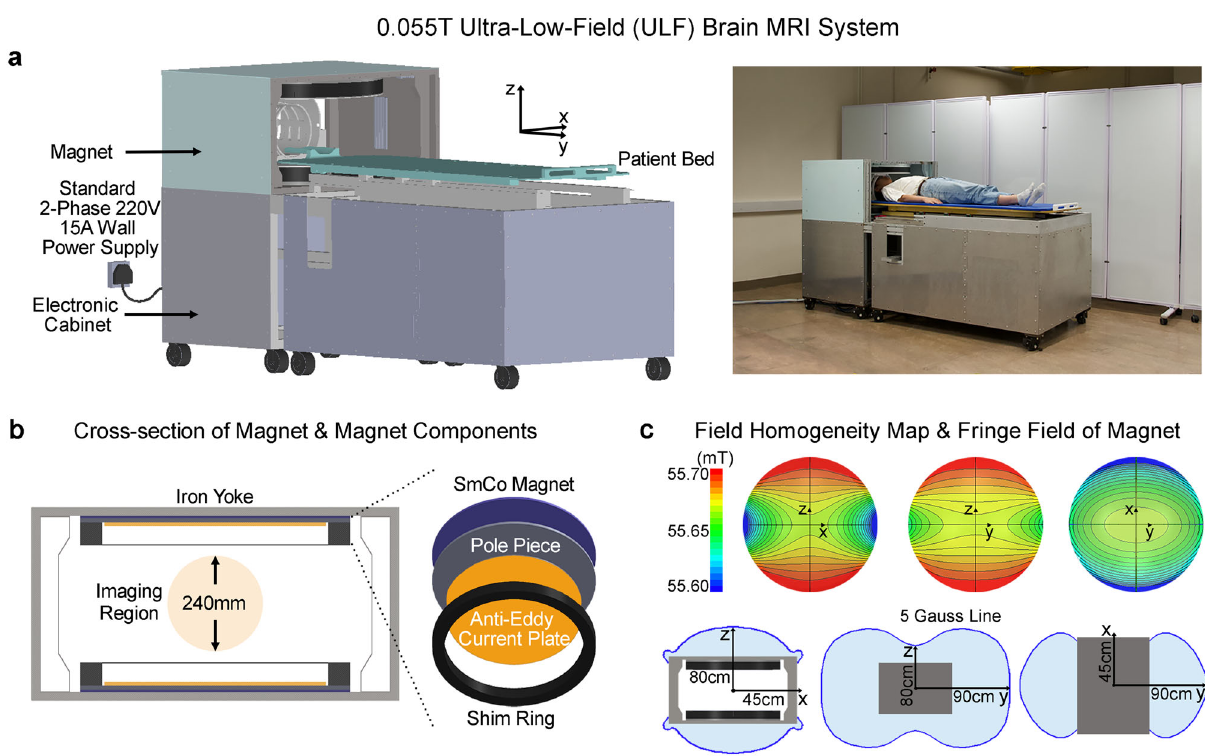
Fig. 1 Prototype of a low-cost low-power and shielding-free brain ultra-low- fi eld (ULF) magnetic resonance imaging (MRI) scanner with homogenous 0.055 Tesla magnetic fi eld and small 5 Gauss fringe fi eld. a With ~2 m 2 footprint and no radiofrequency/magnetic shielding cages, the scanner can be mobile and located on any building fl oor with no special siting requirements. It operates from only a standard alternating current (AC) wall power outlet (50 Hz 2-phase 220 V 15 A). b The 0.055 T magnet utilizes an iron yoke, samarium-cobalt (SmCo) plates, polar pieces, anti-eddy current plates and passive shimming rings, and with adequate opening for patient chest and shoulder (29 cm vertical gap and 70 cm width). c The magnet provides a homogeneity <2000 ppm peak-to-peak over 240 mm diameter of spherical volume (DSV), which can be reduced to <250 ppm after additional passive shimming. The 5 Gauss fringe fi eld is within 45 cm, 90 cm, and 80 cm in X, Y and Z directions from magnet